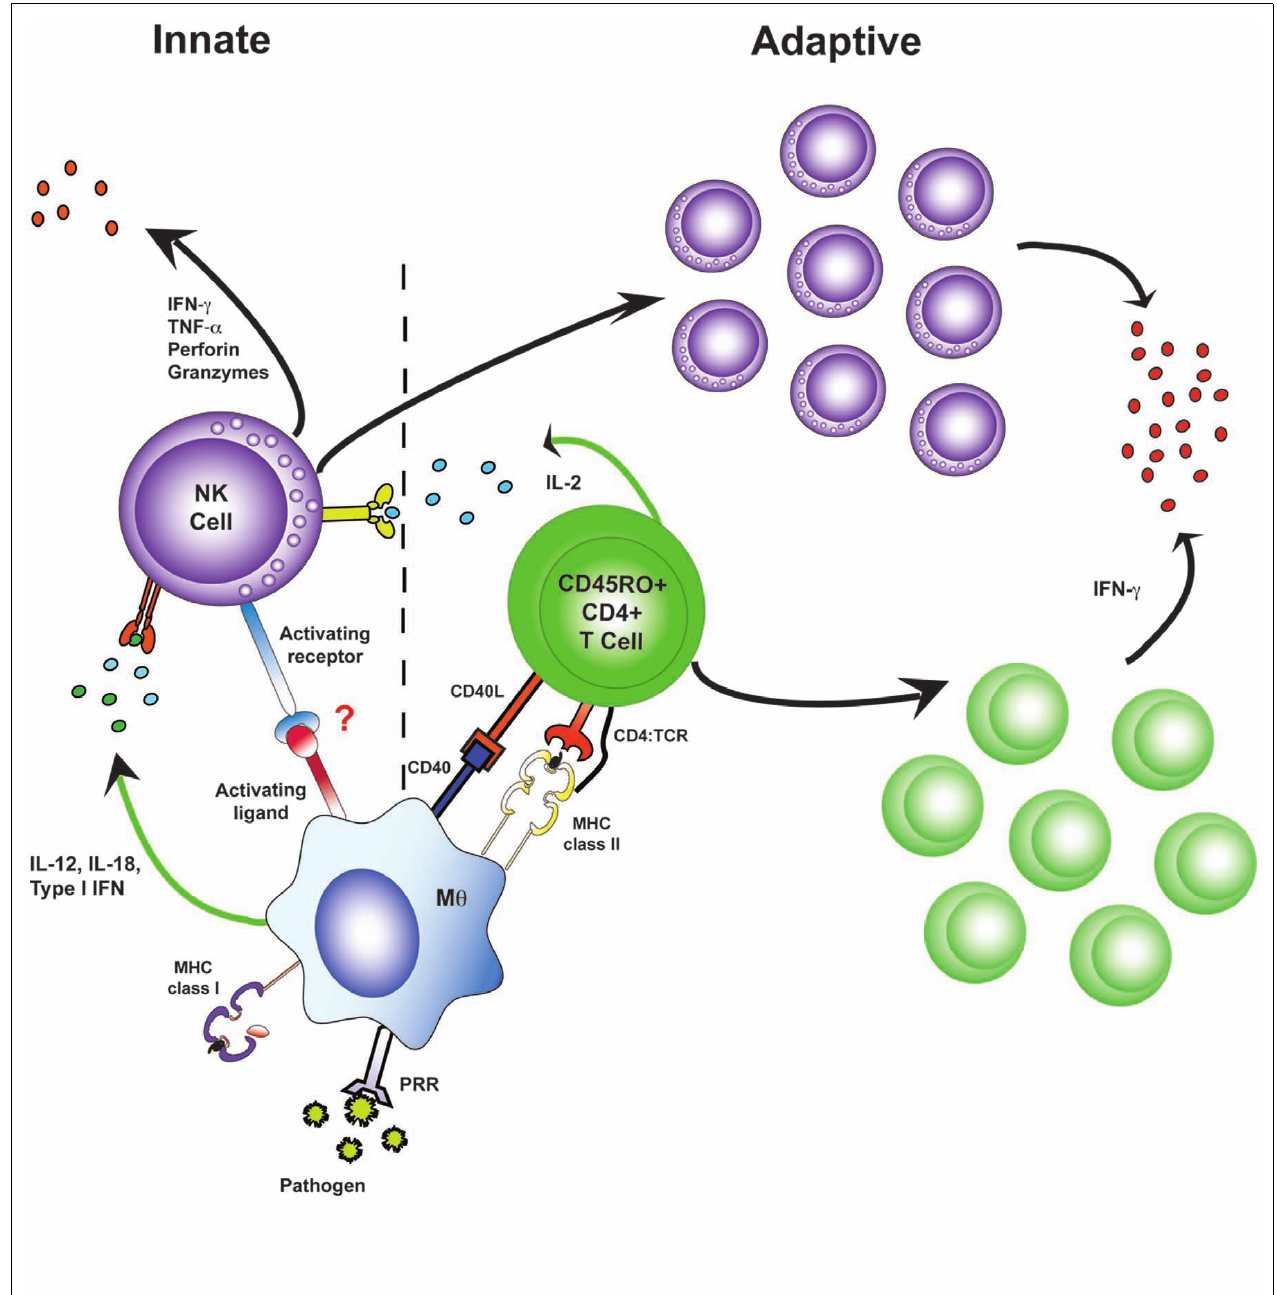
antigen-specific CD4 + T cells are a potent and immediate source of IL-2. Accessory cell signals synergize with this IL-2, resulting in rapid and robust “adaptive” NK cell responses, including NK cell proliferation, secretion of effector molecules, and killing of affected target cells